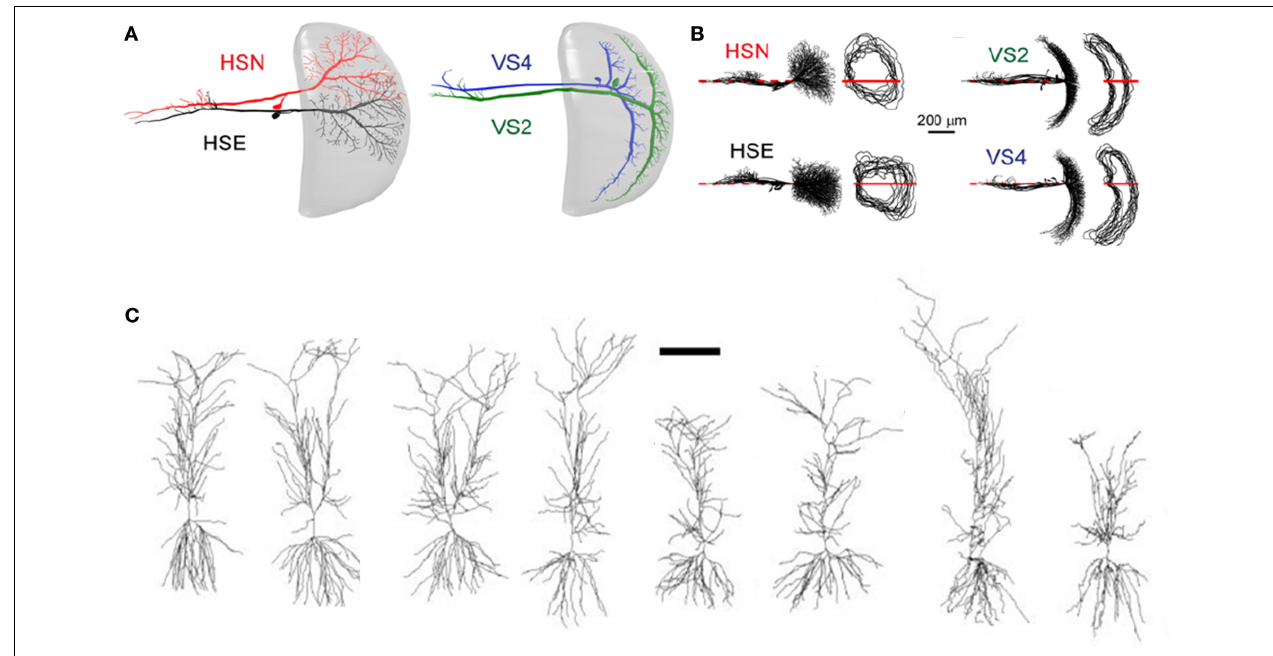
FIGURE 1 | Structural stereotypy in invertebrate and vertebrate neurons. (A,B) Identifi ed neurons in the fl y visual system. (A) Reconstructions of different types of lobula plate tangential cells from the blowfl y (HSE, HSN, VS2 and VS4) within the lobula plate (gray). (B) Left: Neuronal reconstructions of identifi ed neurons superimposed and sorted according to their cell type. Cells were aligned along their axonal axis (red lines). Right: the corresponding dendrite spanning fi elds of the reconstructed neurons. Neuronal anatomical identity is determined by the